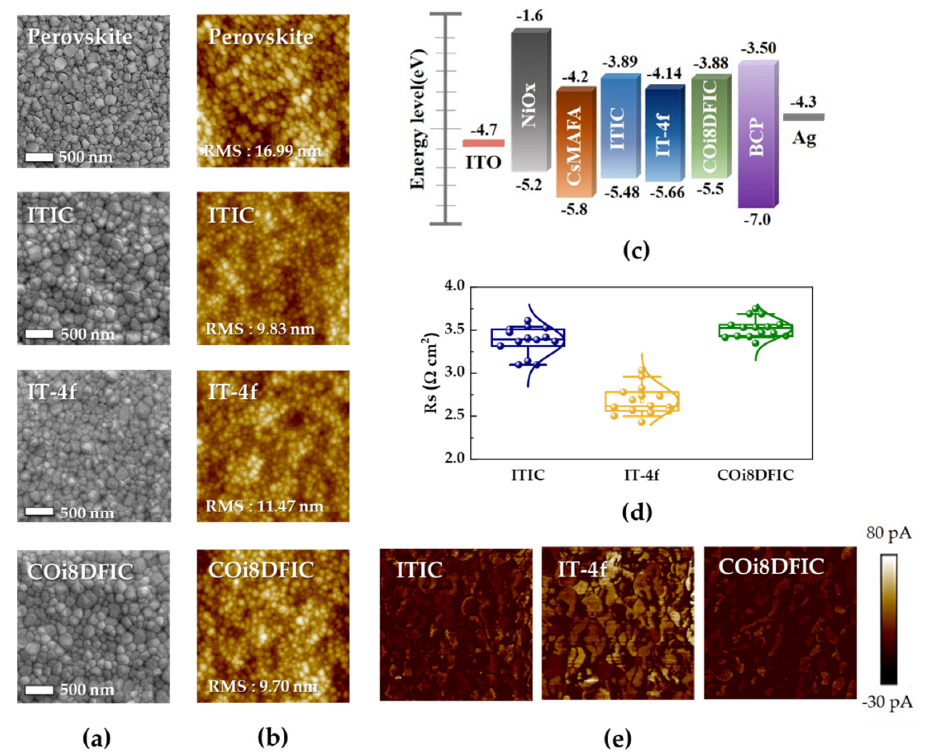
Figure 4. ( a ) Top-view SEM and ( b ) AFM images (scale: 5 × 5 µ m) of ITIC, IT-4f, and COi8DFIC films coated on the ITO / NiO x / perovskite layer. ( c ) Schematic energy level diagram of the perovskite and non-fullerene ETMs. ( d ) Series resistance (Rs) calculated from the J–V curve of the device manufactured under optimal concentration conditions. ( e ) C-AFM images (scale: 2 × 2 µ m) of ITIC, IT-4f, and COi8DFIC films.